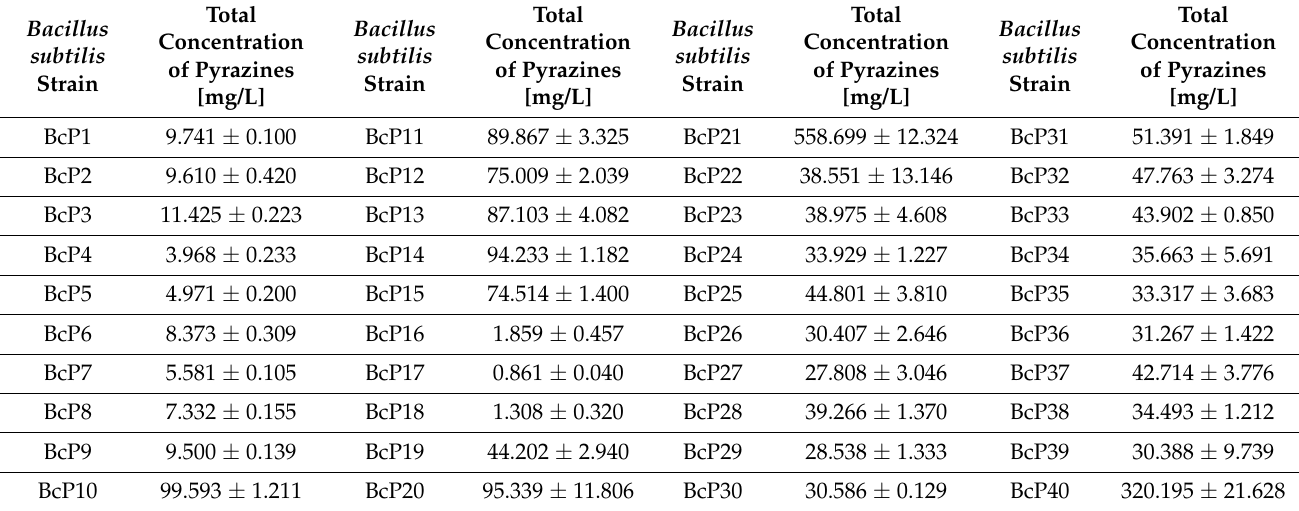
Figure 8. The 2,3,5,6-tetramethylpyrazine biosynthesis by B. subtilis strains. Table 1. Total concentration of pyrazines produced by B. subtilis The BcP21 strain was the best producer of pyrazines (in total) of all the strains se- lected from fermented soybeans, producing these compounds at a total concentration of approximately ca. 560 mg/L (Table 1). The second most effective strain was BcP40, capable of producing pyrazines at a level of 320 mg/L. None of the other analyzed strains pro- duced pyrazines in concentrations greater than 100 mg/L (Table 1). The dominant com- pound among the produced pyrazines was 2,3,5,6-tetramethylpyrazine. When analyzing the results of screening tests, one should also consider the profile of the obtained pyrazine